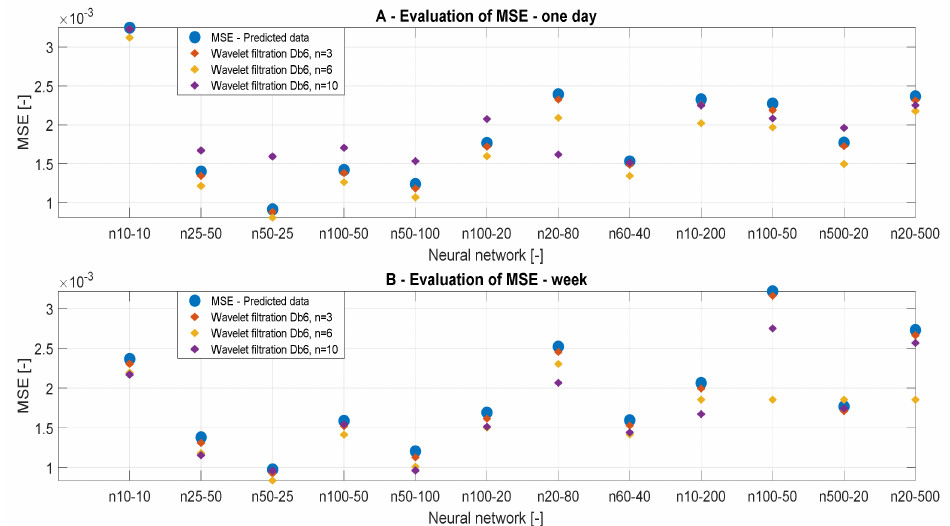
Figure 9. MSE values, a comparison of reference signal with the wavelet-based filtration signals.